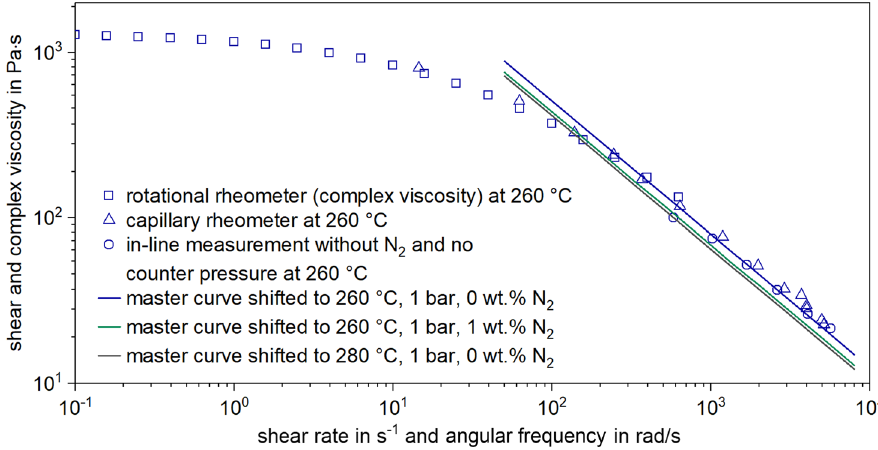
Figure 10: Quanti fi cation of viscosity reduction by increasing the N 2 concentration and